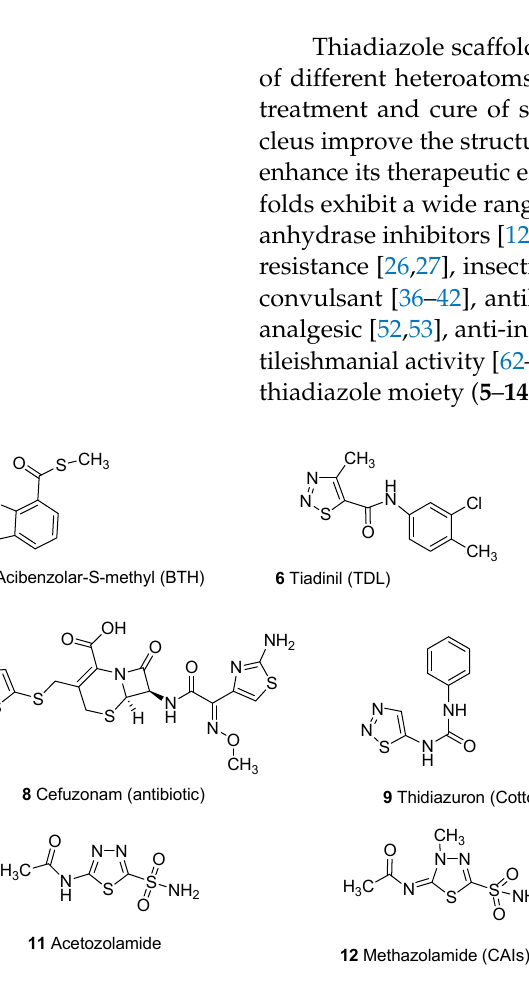
Figure 2. Commercial drugs based on different thiadiazole scaffolds ( 5 – 14